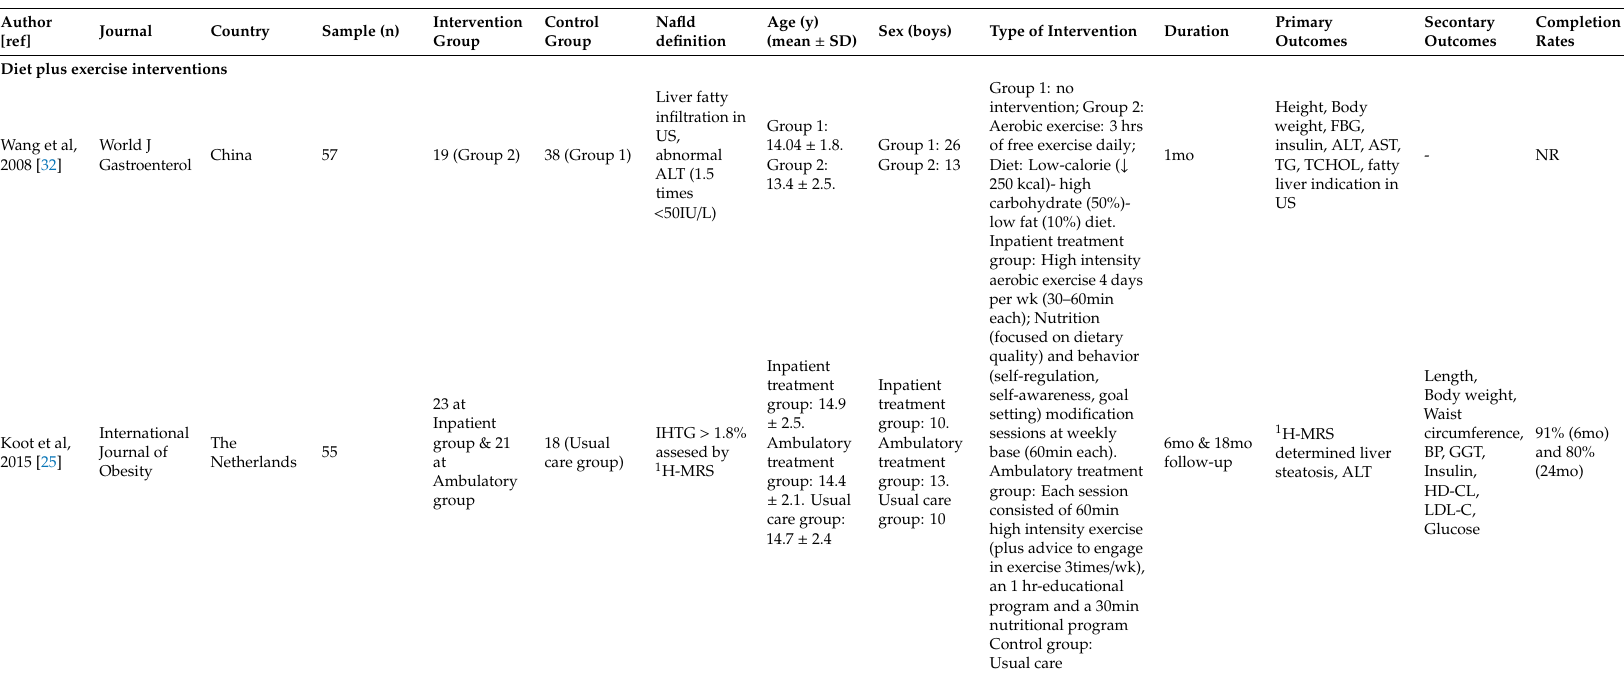
Table 2. Characteristics based on lifestyle (i.e., diet plus exercise) and exercise-focused